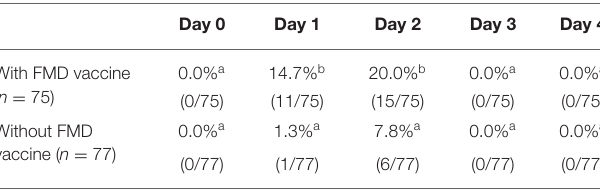
TABLE 3 | Percentage of cows with hyperthermia ( ≥ 39.5 ◦ C) after receiving or not vaccination (Day 0) against foot-and-mouth disease